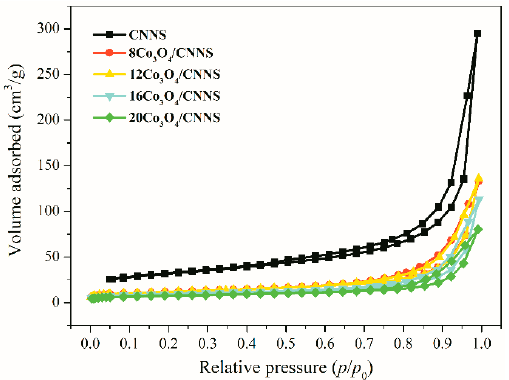
Table 1. Textural property and average pore diameter of the pure and Co 3 O 4 -modified CNNS.